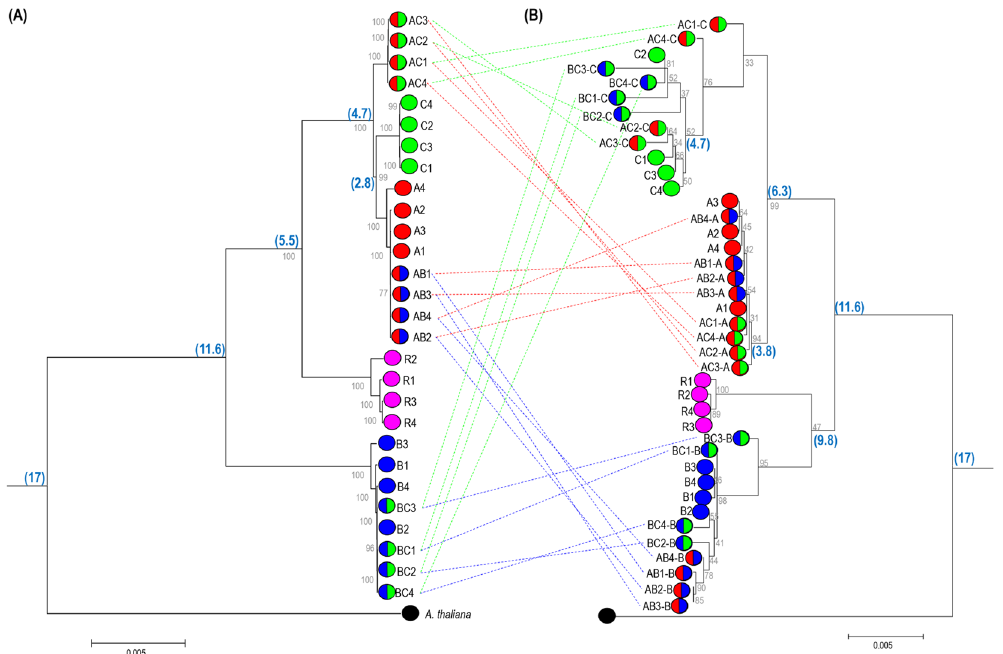
Figure 5. Phylogenetic relationships of the genus Brassica inferred from complete chloroplast ( A ) and 45SnrDNA ( B ) sequences of 28 Brassica and Raphanus genotypes. Tree was developed using MEGA7 with 1,000 bootstrap replications. The bootstrap values for clades are shown in corresponding branches of the tree. Taxon markers with single and double circles represent diploid and tetraploid genomes, respectively. The circled legend for 45SnrDNA and chloroplast corresponds to each species. Dotted line connects the corresponding allotetradiploid genomes of chloroplast and 45SnrDNA. Species divergence times were inferred from Bayesian analysis, and are shown at the side of the node in million years (my). A . thaliana was used as an